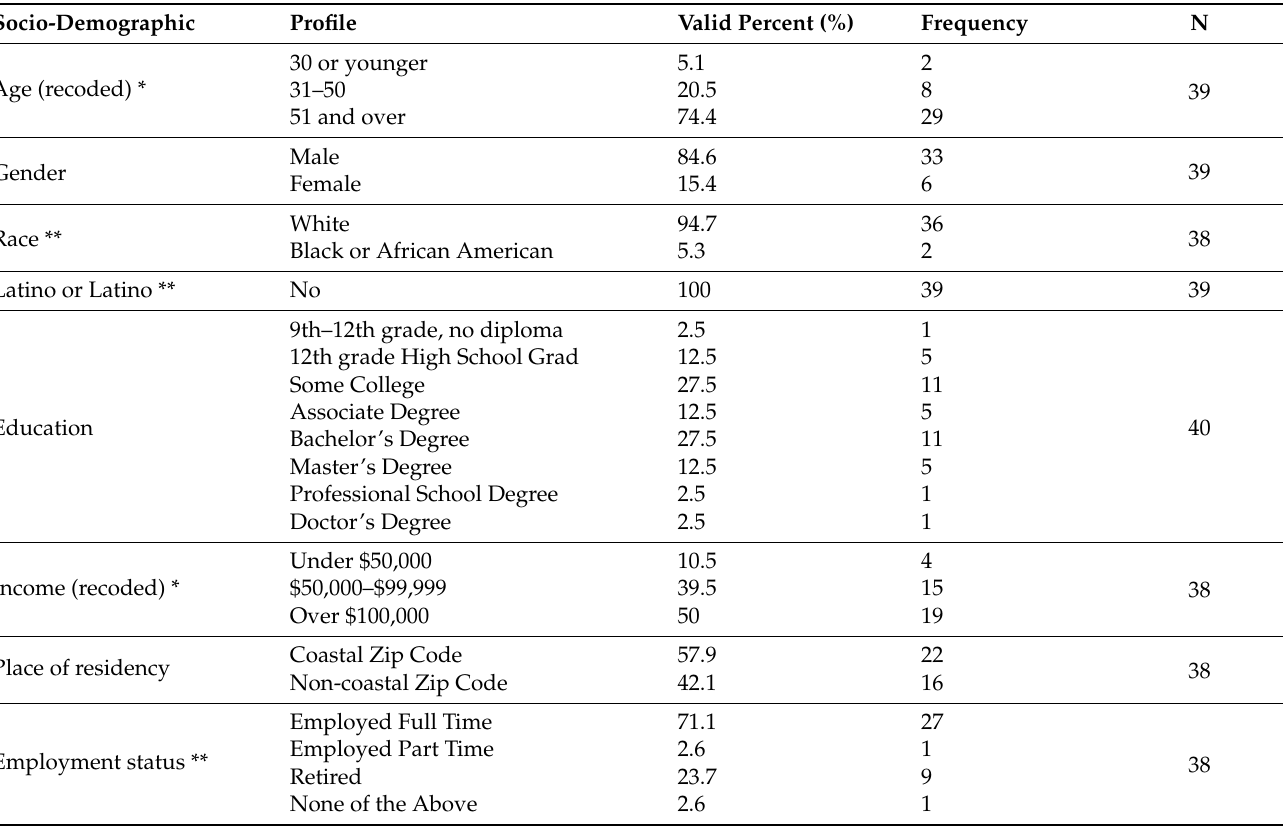
Table 2. Socio-demographic Profile of Survey Respondents, Shown with Frequency and the Percent- age of Responses for Each Survey Question, with the According Sample Size